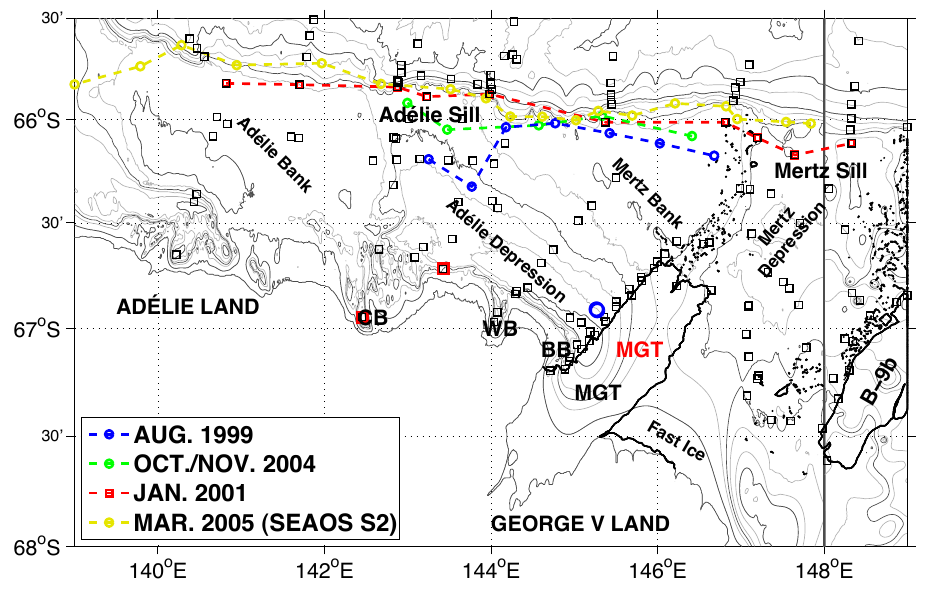
Fig. 3. The location of high quality ship-borne summertime CTD measurements from NBP00–08 (squares). Specific CTD locations also shown for Fig. 4 from summer near Commonwealth Bay (NBP00–08, stations 17 and 61, red squares) and from winter near the MGT over the AD (AU9901, stations 27, 51 and 84, blue circles). Seasonal shelf break transects for Fig. 6 indicated by dashed lines for winter (AU9901, blue), spring (NBP0410, green), summer (NBP00–08, red) and summer/fall (SEaOS, S2,